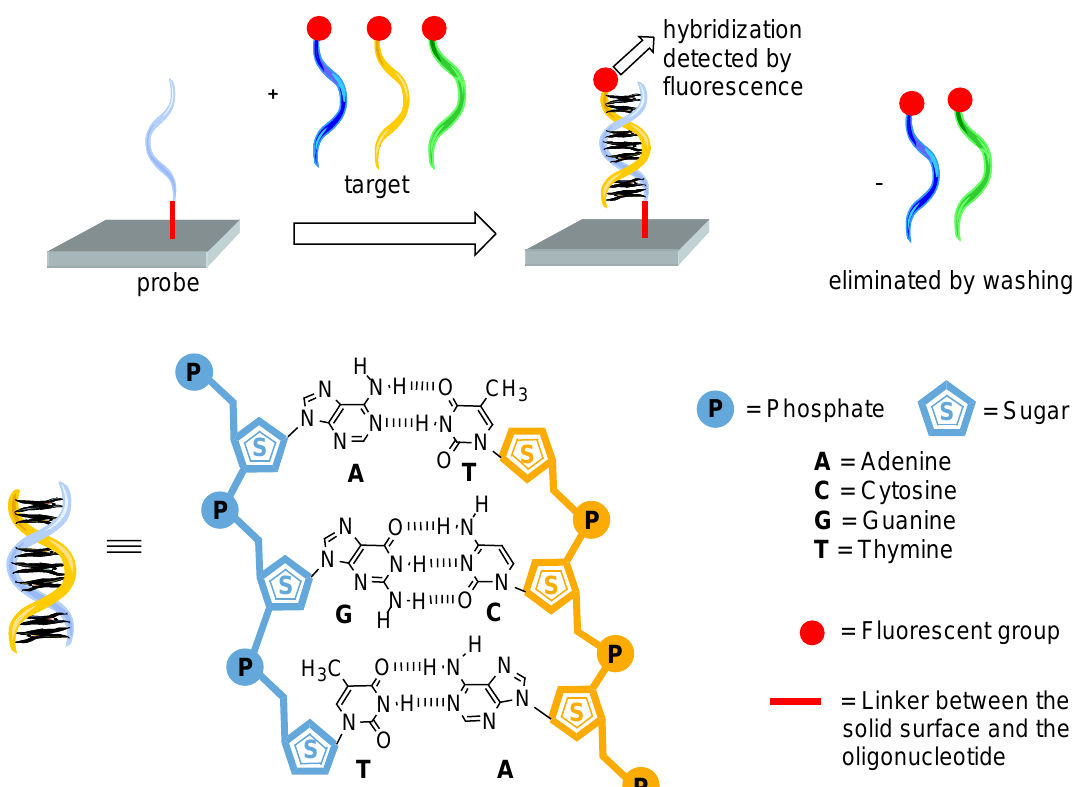
Figure 1. Principle of a DNA chip or DNA array. Only the oligonucleotide complementary to the one immobilized on the surface can hybridize. The hybridization occurs through supramolecular recognition of complementary bases (Adenine with Thymine, and Cytosine with Guanine) linked to the sugar and phosphate backbones, as illustrated by one